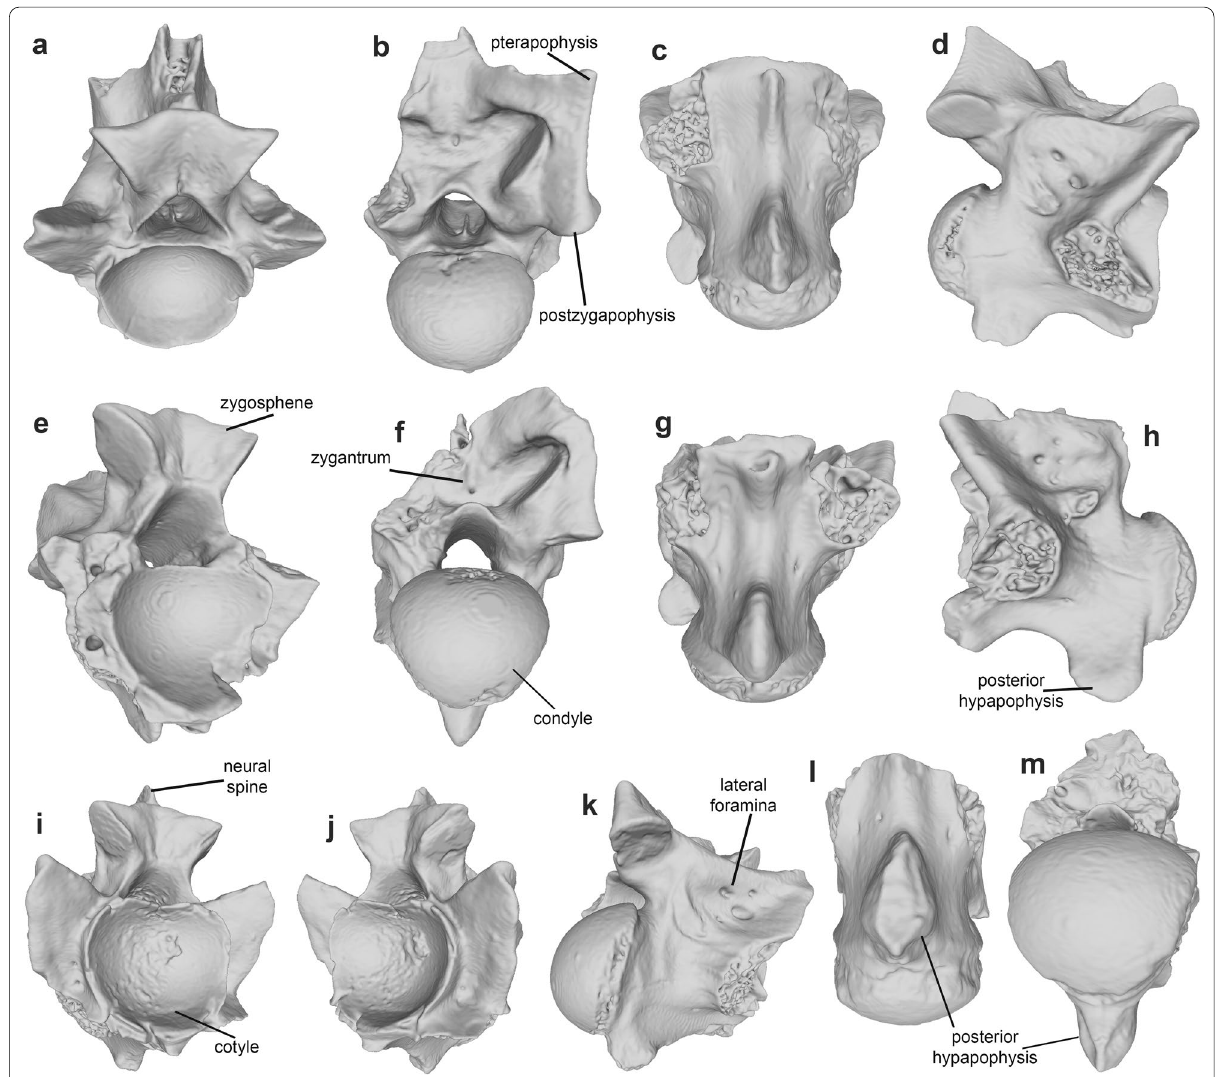
Fig. 7 3D models of anterior or anterior mid-trunk vertebrae: a–d UM KPO 26 in anterodorsal ( a ), posterior ( b ), ventral ( c ), and right lateral ( d ) views; e–h UM KPO 28 in right anterolateral ( e ), posterior ( f ), ventral ( g ), and left lateral ( h ) views; i–k UM KPO 27 in right anterolateral ( i ) left anterolateral ( j ), and right ventrolateral ( k ) views; l–m UM KPO 35 in ventral ( l ) and posterior ( m ) views. Specimens not to the same